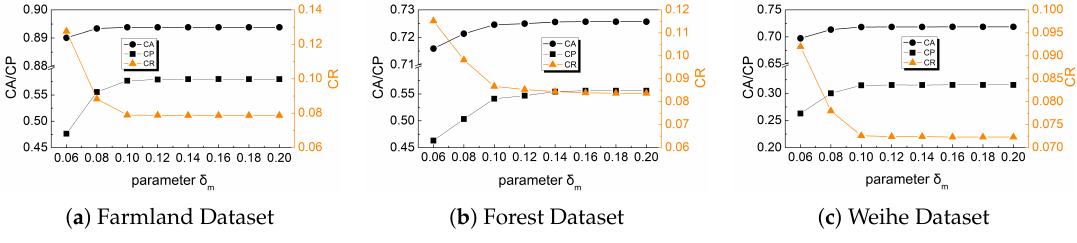
Figure 8. Relationship between parameter δ m and the result of